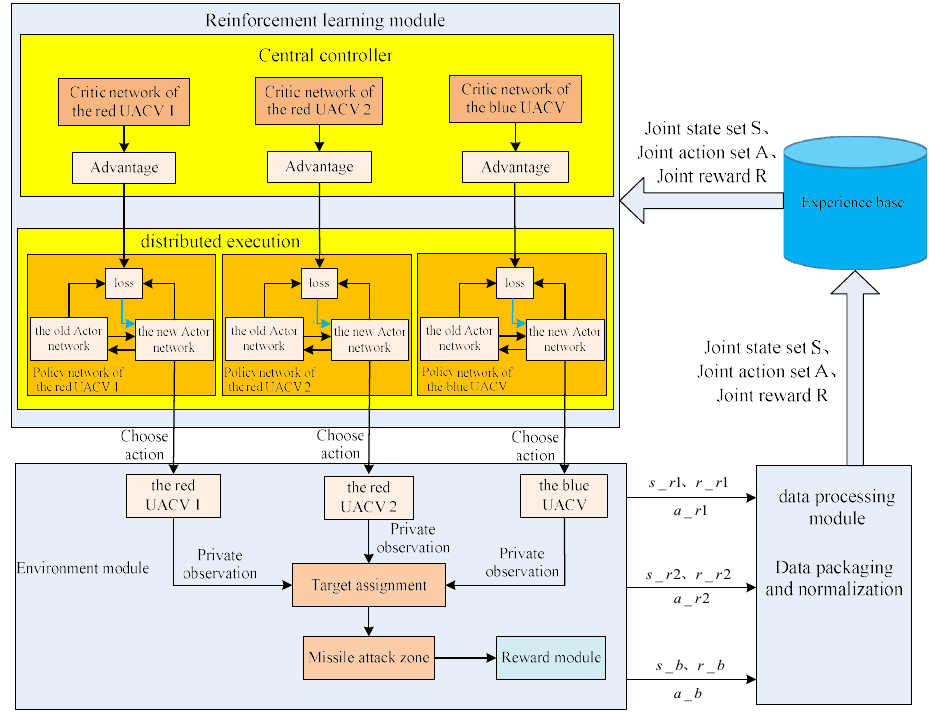
Figure 2. Decision-making framework of two UCAVs and a single UCAV that are engaging in air combat.